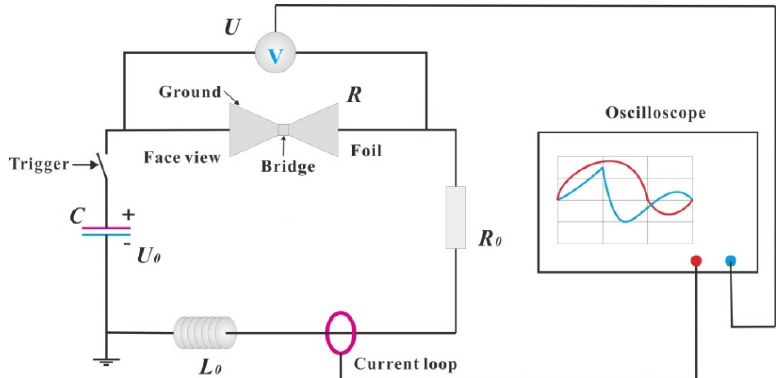
Figure 2. Electric explosion experimental system for multilayer foil. ( R —foil resistance; U —foil voltage; R 0 —line resistance; U 0 —initial charging voltage; L 0 —loop resistance.).